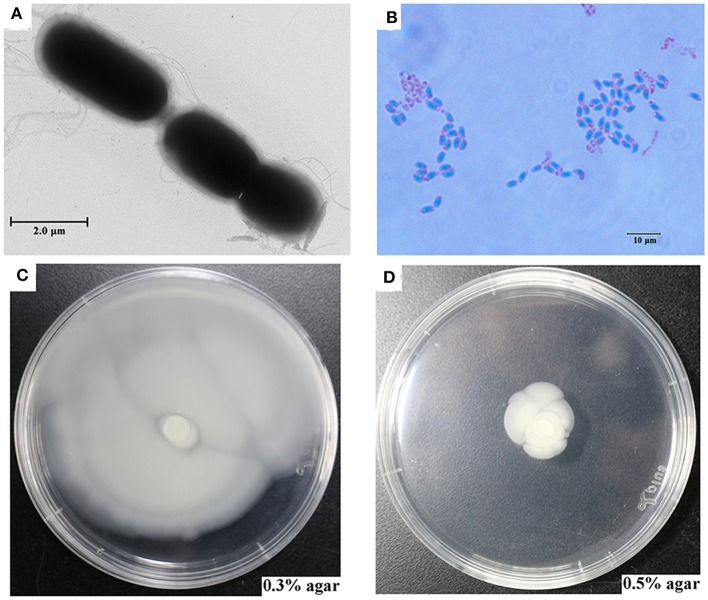
Morphology and motility of SR52. (A) SR52 observed with a transmission electron microscope. (B) Micrograph of carbol fuchsin-stained spores of SR52. (C,D) SR52 suspension was spotted onto a marine 2216E plate containing 0.3 or 0.5% (w/v) agar, and bacterial growth was observed after 24 h incubation.